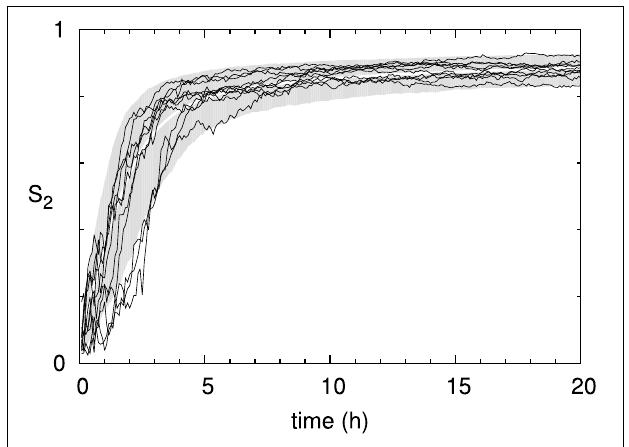
FIGURE 9 | Cross validation of theory and simulations. Order parameter S 2 as a function of the scaled control parameter G c /α 1 / 3 for decreasing values of the interaction strength parameter α : 0 . 3 , 0 . 1 , 0 . 03 , 0 . 01. The arrow and dashed line denote the location of the predicted critical value of the control parameter G ∗ /α 1 / 3 ≈ − 0 . 15. All data points are averages of n independent runs, and standard errors of the mean are indicated. For α = 0 . 3 , 0 . 1 we used n = 100 and S 2 was computed at t = 20 h. For α = 0 . 03 , 0 . 01 a larger equilibration time of t = 100 h was used, and n = 42. Default parameters were used, except for disabling of